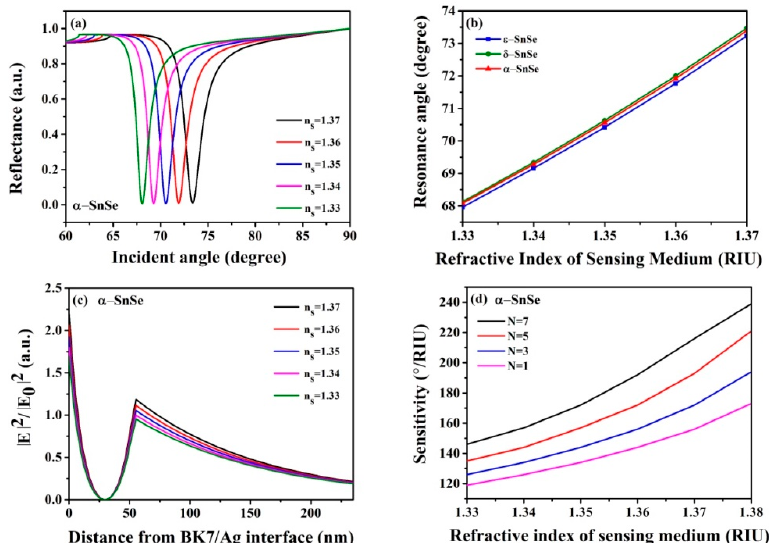
Figure 4. ( a ) Change of reflectivity relative to incidence angles, ( b ) the electric field distributions of the biochemical sensors proposed by SnSe from n s = 1.33 to n s = 1.37, ( c ) incidence angles of three SnSe allotropes from n s = 1.33 to n s = 1.37, ( d ) the variation of the sensitivities of the proposed biochemical